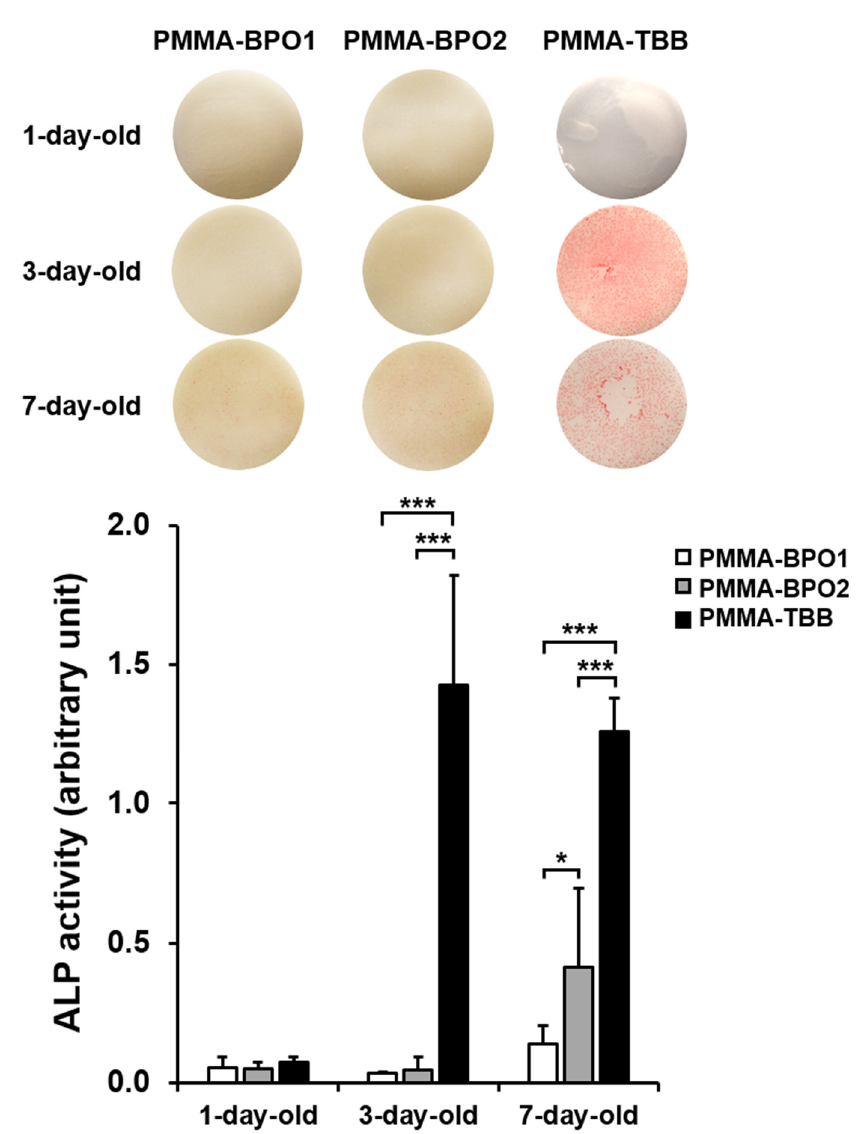
Figure 4. Alkaline phosphatase (ALP) activity of osteoblasts on different bone cement types of different ages evaluated on day five of culture. Representative images of the stained cultures are presented ( top ). ALP activity colorimetrically quantified and standardized relative to cell number is shown in the histogram ( bottom ). Data are shown as mean ± SD ( n = 3). Statistical differences between the three groups are shown (two-way ANOVA followed by Bonferroni test, * p < 0.05, *** p < 0.001).